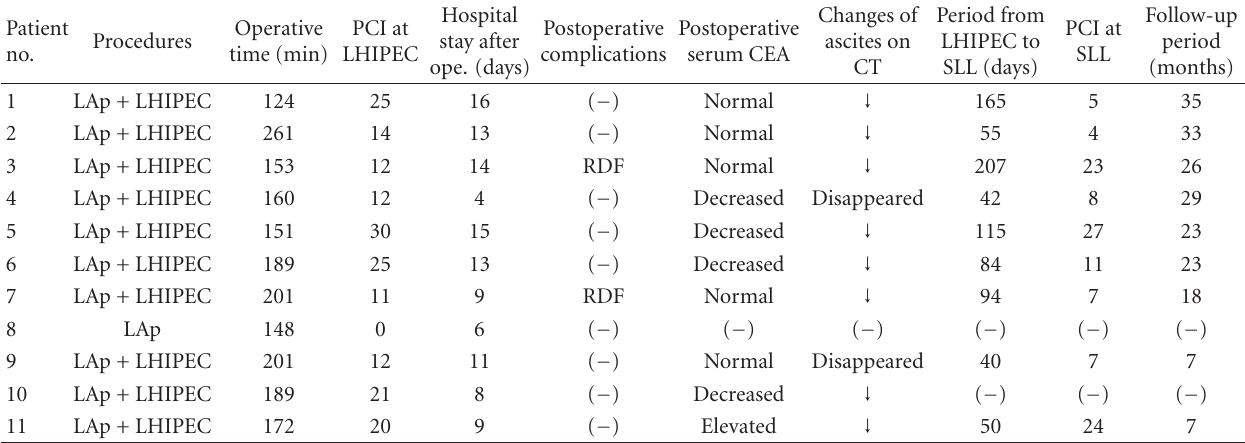
Table 2: Results of laparoscopic operation and secondary look laparotomy (cytoreductive surgery + HIPEC).